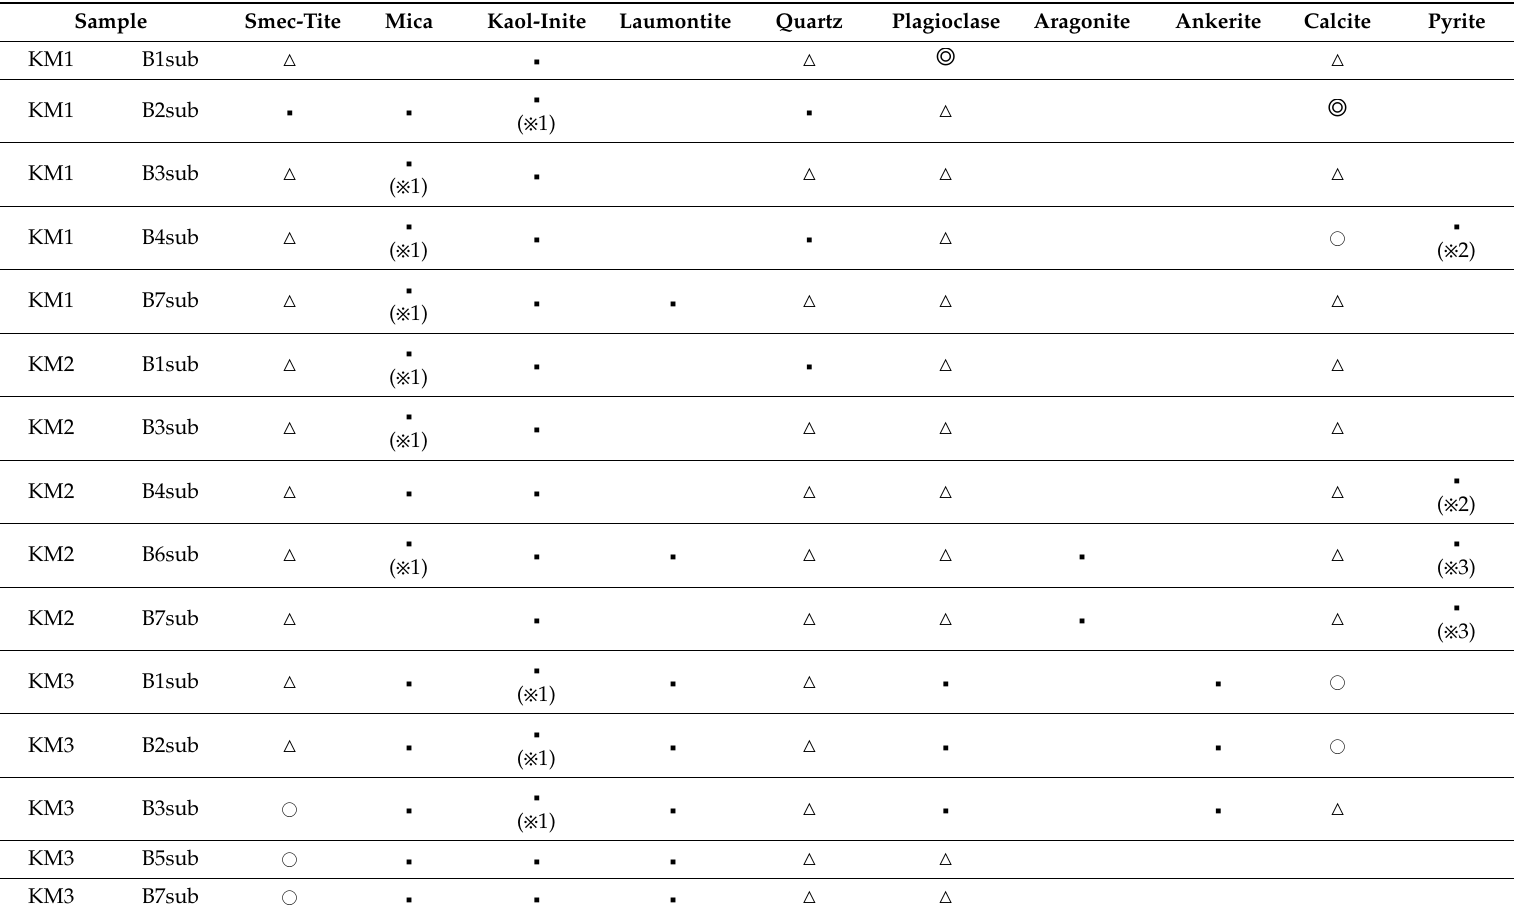
Table 2. Qualitative X-ray Di ff raction Analysis (XRD) results for the Kato Moni boreholes KM1, KM2 and KM3. Table 2. Qualitative X-ray Diffraction Analysis (XRD) results for the Kato Moni boreholes KM1, KM2 and KM3. Table 2. Qualitative X-ray Diffraction Analysis (XRD) results for the Kato Moni boreholes KM1, KM2 and KM3. Table 2. Qualitative X-ray Diffraction Analysis (XRD) results for the Kato Moni boreholes KM1, KM2 and KM3. Table 2. Qualitative X-ray Diffraction Analysis (XRD) results for the Kato Moni boreholes KM1, KM2 and KM3. Table 2. Qualitative X-ray Diffraction Analysis (XRD) results for the Kato Moni boreholes KM1, KM2 and KM3. Table 2. Qualitative X-ray Diffraction Analysis (XRD) results for the Kato Moni boreholes KM1, KM2 and KM3. Table 2. Qualitative X-ray Diffraction Analysis (XRD) results for the Kato Moni boreholes KM1, KM2 and KM3. Sample Sample Sample Table 2. Qualitative X-ray Diffraction Analysis (XRD) results for the Kato Moni boreholes KM1, KM2 and KM3. Table 2. Qualitative X-ray Diffraction Analysis (XRD) results for the Kato Moni boreholes KM1, KM2 and KM3. Sample Table 2. Qualitative X-ray Diffraction Analysis (XRD) results for the Kato Moni boreholes KM1, KM2 and KM3. Table 2. Qualitative X-ray Diffraction Analysis (XRD) results for the Kato Moni boreholes KM1, KM2 and KM3. Table 2. Qualitative X-ray Diffraction Analysis (XRD) results for the Kato Moni boreholes KM1, KM2 and KM3. Table 2. Qualitative X-ray Diffraction Analysis (XRD) results for the Kato Moni boreholes KM1, KM2 and KM3. Sample Sample Sample Table 2. Qualitative X-ray Diffraction Analysis (XRD) results for the Kato Moni boreholes KM1, KM2 and KM3. Table 2. Qualitative X-ray Diffraction Analysis (XRD) results for the Kato Moni boreholes KM1, KM2 and KM3. Table 2. Qualitative X-ray Diffraction Analysis (XRD) results for the Kato Moni boreholes KM1, KM2 and KM3. Sample Sample Table 2. Qualitative X-ray Diffraction Analysis (XRD) results for the Kato Moni boreholes KM1, KM2 and KM3. Table 2. Qualitative X-ray Diffraction Analysis (XRD) results for the Kato Moni boreholes KM1, KM2 and KM3. Table 2. Qualitative X-ray Diffraction Analysis (XRD) results for the Kato Moni boreholes KM1, KM2 and KM3. Sample Table 2. Qualitative X-ray Diffraction Analysis (XRD) results for the Kato Moni boreholes KM1, KM2 and KM3. Table 2. Qualitative X-ray Diffraction Analysis (XRD) results for the Kato Moni boreholes KM1, KM2 and KM3. Sample Smec-Tite Mica Kaol-Inite Laumontite Quartz Plagioclase Aragonite Ankerite Calcite Pyrite Sample Table 2. Qualitative X-ray Diffraction Analysis (XRD) results for the Kato Moni boreholes KM1, KM2 and KM3. Table 2. Qualitative X-ray Diffraction Analysis (XRD) results for the Kato Moni boreholes KM1, KM2 and KM3. Table 2. Qualitative X-ray Diffraction Analysis (XRD) results for the Kato Moni boreholes KM1, KM2 and KM3. Sample Smec-Tite Mica Kaol-Inite Laumontite Quartz Plagioclase Aragonite Ankerite Calcite Pyrite Table 2. Qualitative X-ray Diffraction Analysis (XRD) results for the Kato Moni boreholes KM1, KM2 and KM3. Table 2. Qualitative X-ray Diffraction Analysis (XRD) results for the Kato Moni boreholes KM1, KM2 and KM3. Table 2. Qualitative X-ray Diffraction Analysis (XRD) results for the Kato Moni boreholes KM1, KM2 and KM3. Table 2. Qualitative X-ray Diffraction Analysis (XRD) results for the Kato Moni boreholes KM1, KM2 and KM3. Table 2. Qualitative X-ray Diffraction Analysis (XRD) results for the Kato Moni boreholes KM1, KM2 and KM3. Sample Sample Sample Sample Table 2. Qualitative X-ray Diffraction Analysis (XRD) results for the Kato Moni boreholes KM1, KM2 and KM3. Table 2. Qualitative X-ray Diffraction Analysis (XRD) results for the Kato Moni boreholes KM1, KM2 and KM3. Table 2. Qualitative X-ray Diffraction Analysis (XRD) results for the Kato Moni boreholes KM1, KM2 and KM3. Sample Smec-Tite Mica Kaol-Inite Laumontite Quartz Plagioclase Aragonite Ankerite Calcite Pyrite Table 2. Qualitative X-ray Diffraction Analysis (XRD) results for the Kato Moni boreholes KM1, KM2 and KM3. Table 2. Qualitative X-ray Diffraction Analysis (XRD) results for the Kato Moni boreholes KM1, KM2 and KM3. Table 2. Qualitative X-ray Diffraction Analysis (XRD) results for the Kato Moni boreholes KM1, KM2 and KM3. Table 2. Qualitative X-ray Diffraction Analysis (XRD) results for the Kato Moni boreholes KM1, KM2 and KM3. Table 2. Qualitative X-ray Diffraction Analysis (XRD) results for the Kato Moni boreholes KM1, KM2 and KM3. Sample Aragonite Ankerite Calcite Sample Smec-Tite Mica Kaol-Inite Laumontite Quartz Plagioclase Aragonite Ankerite Calcite Pyrite Table 2. Qualitative X-ray Diffraction Analysis (XRD) results for the Kato Moni boreholes KM1, KM2 and KM3. Table 2. Qualitative X-ray Diffraction Analysis (XRD) results for the Kato Moni boreholes KM1, KM2 and KM3. Table 2. Qualitative X-ray Diffraction Analysis (XRD) results for the Kato Moni boreholes KM1, KM2 and KM3. Table 2. Qualitative X-ray Diffraction Analysis (XRD) results for the Kato Moni boreholes KM1, KM2 and KM3. Table 2. Qualitative X-ray Diffraction Analysis (XRD) results for the Kato Moni boreholes KM1, KM2 and KM3. Sample Smec-Tite Mica Kaol-Inite Laumontite Quartz Plagioclase Aragonite Ankerite Calcite Pyrite Laumontite Quartz Plagioclase Aragonite Ankerite Calcite Pyrite Sample Table 2. Qualitative X-ray Diffraction Analysis (XRD) results for the Kato Moni boreholes KM1, KM2 and KM3. ◎ △ Table 2. Qualitative X-ray Diffraction Analysis (XRD) results for the Kato Moni boreholes KM1, KM2 and KM3. Table 2. Qualitative X-ray Diffraction Analysis (XRD) results for the Kato Moni boreholes KM1, KM2 and KM3. Table 2. Qualitative X-ray Diffraction Analysis (XRD) results for the Kato Moni boreholes KM1, KM2 and KM3. Table 2. Qualitative X-ray Diffraction Analysis (XRD) results for the Kato Moni boreholes KM1, KM2 and KM3. Sample Sample Sample Table 2. Qualitative X-ray Diffraction Analysis (XRD) results for the Kato Moni boreholes KM1, KM2 and KM3. Table 2. Qualitative X-ray Diffraction Analysis (XRD) results for the Kato Moni boreholes KM1, KM2 and KM3. Table 2. Qualitative X-ray Diffraction Analysis (XRD) results for the Kato Moni boreholes KM1, KM2 and KM3. Table 2. Qualitative X-ray Diffraction Analysis (XRD) results for the Kato Moni boreholes KM1, KM2 and KM3. Table 2. Qualitative X-ray Diffraction Analysis (XRD) results for the Kato Moni boreholes KM1, KM2 and KM3. Table 2. Qualitative X-ray Diffraction Analysis (XRD) results for the Kato Moni boreholes KM1, KM2 and KM3. Sample Sample Smec-Tite Mica Kaol-Inite Laumontite Quartz Aragonite Ankerite Sample Smec-Tite Mica Kaol-Inite Laumontite Quartz Plagioclase Aragonite Ankerite Calcite Pyrite Table 2. Qualitative X-ray Diffraction Analysis (XRD) results for the Kato Moni boreholes KM1, KM2 and KM3. Table 2. Qualitative X-ray Diffraction Analysis (XRD) results for the Kato Moni boreholes KM1, KM2 and KM3. KM1 B1sub △ ▪ △ ◎ △ Sample Sample Sample Sample Smec-Tite Mica Kaol-Inite Laumontite Quartz Plagioclase Aragonite Ankerite